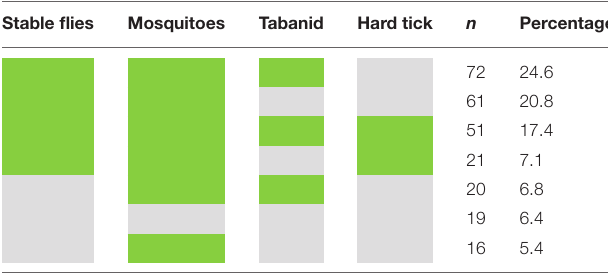
Green and gray colors indicate finding and not finding respectively.